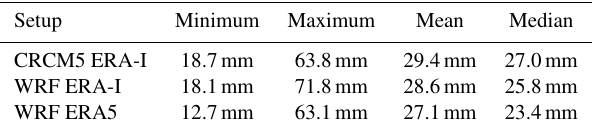
Table 1. Statistical properties of the POT threshold u for the three different model setups in the study